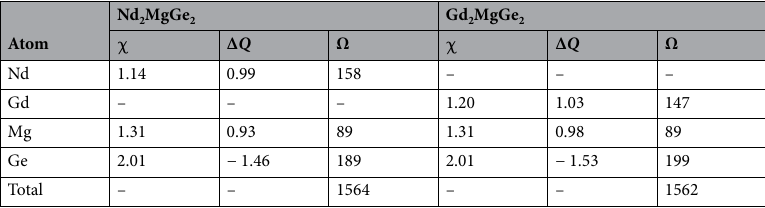
Table 4. Pauling electronegativity ( χ ), oxidation state (Δ Q ), and atomic volume (Ω in Bohr 3 ).